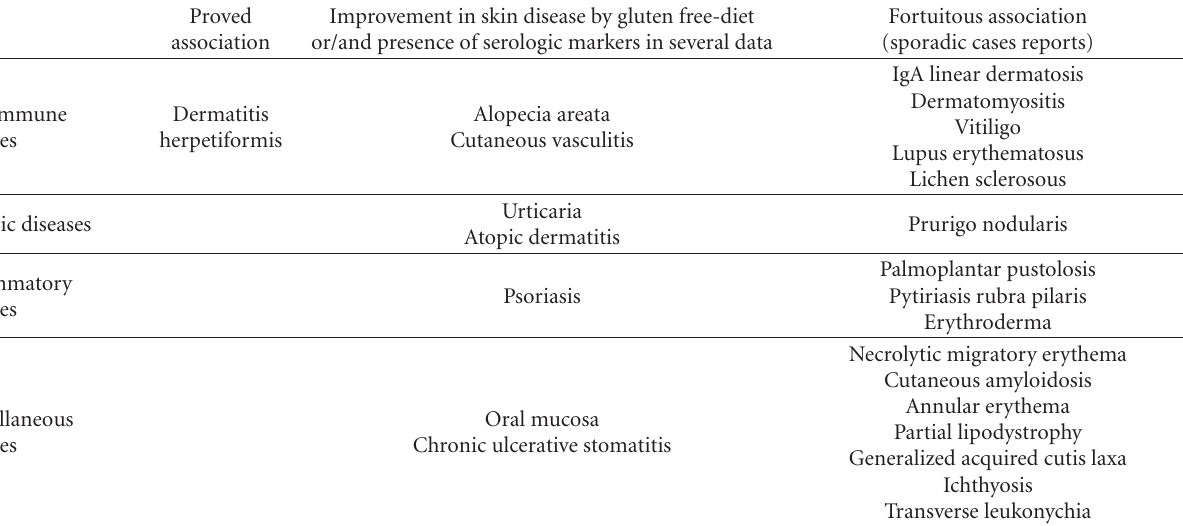
Table 1: Skin diseases associated with CD (adapted from Humbert et al.